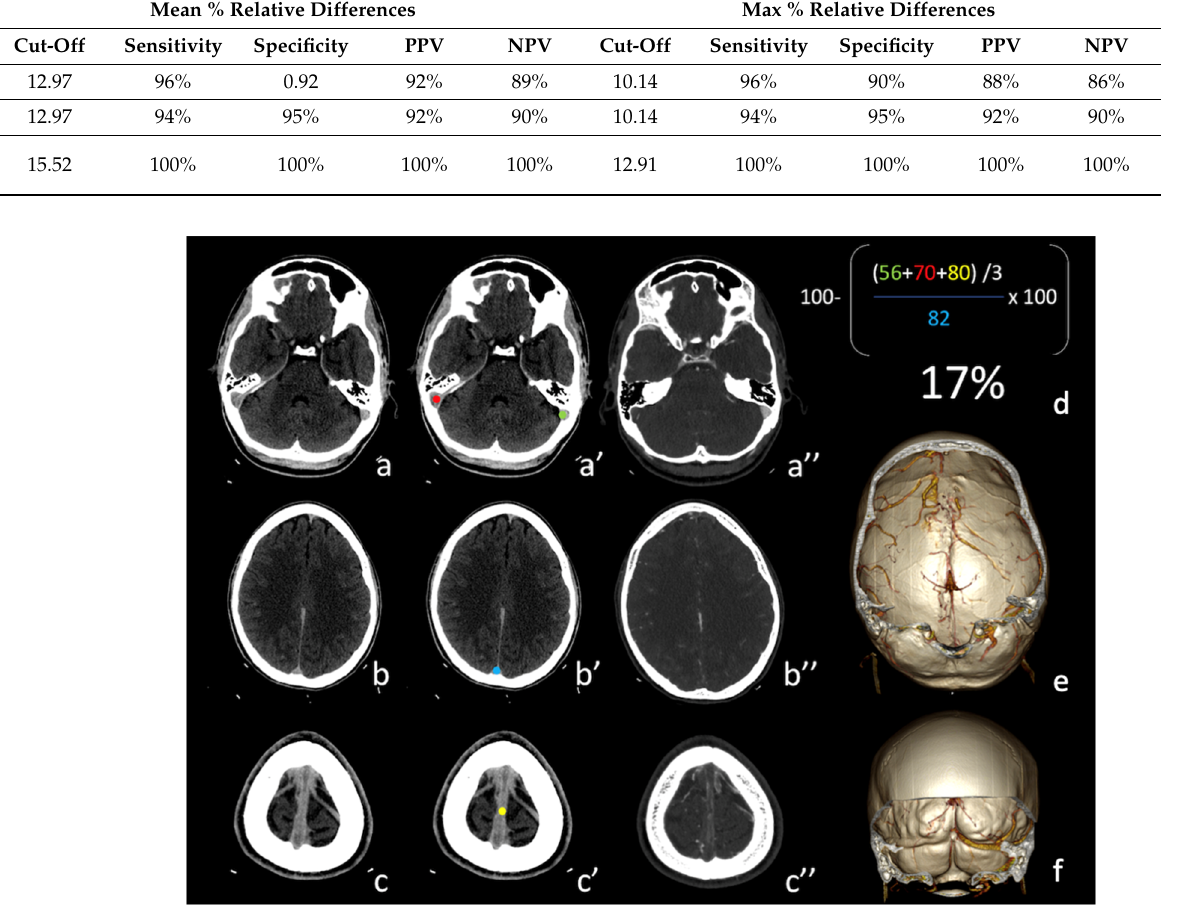
Figure 3. ( a – c ): Non-contrast CT (NCCT) images of a patient with superior sagittal sinus and right transverse sinus thrombosis; ( a’ – c’ ): example of the proposed method applied to the patient’s cerebral venous system with the proposed formula ( d ) indicative of venous thrombosis; ( a’’ – c’’ , e , f ): CT angiography that confirms superior sagittal sinus and right transverse sinus thrombosis.